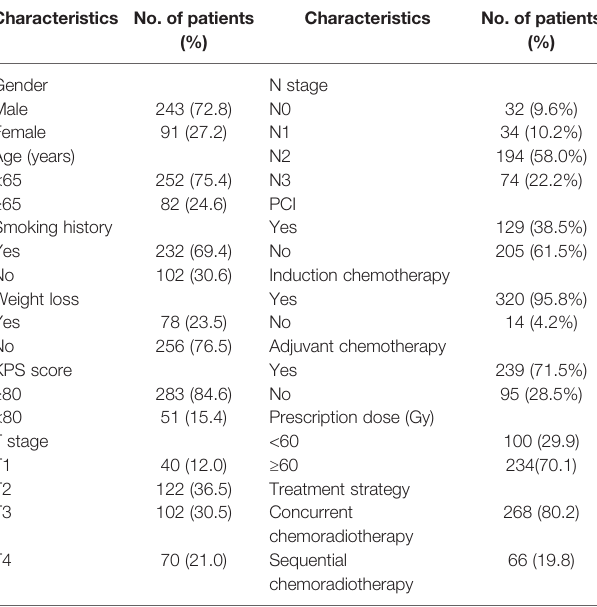
TABLE 1 | Distribution of clinical characteristics of patients with limited-stage small cell lung